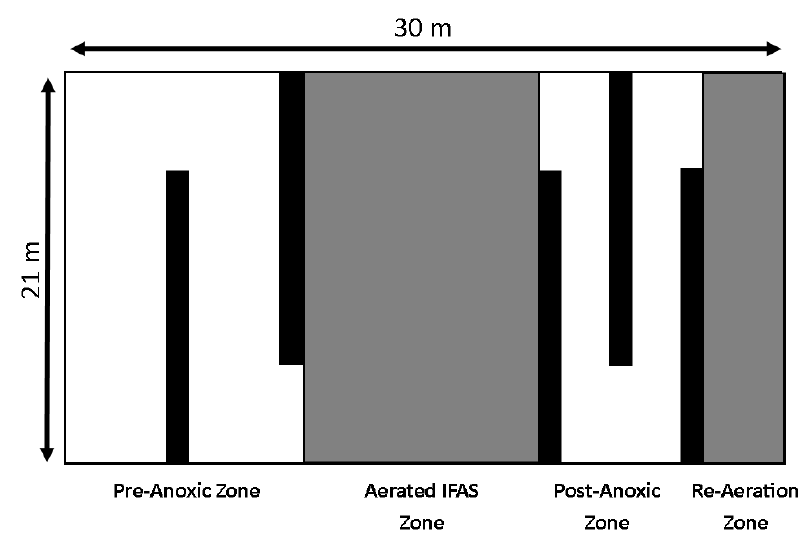
Figure A1. Aerial view of one of the ten Integrated Fixed Film Activated Sludge (IFAS) tanks at the Field’s Point WTP. White area represents anoxic/hypoxic zones, grey area represents aerated zones, and black bars represent barriers. Water flows from left to right. Modified from Brannon et al. [10].